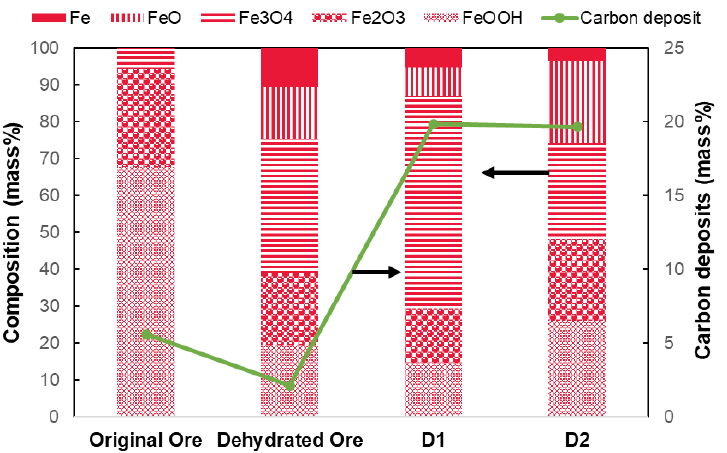
Figure 8. Composition and carbon deposits of the sample before and after tar impregnation and carbonization process. Carbonized ore D1: resulting from biomass tar impregnation which immedi- ately carbonized; carbonized ore D2: resulting from biomass tar impregnation for 24 h before the carbonization